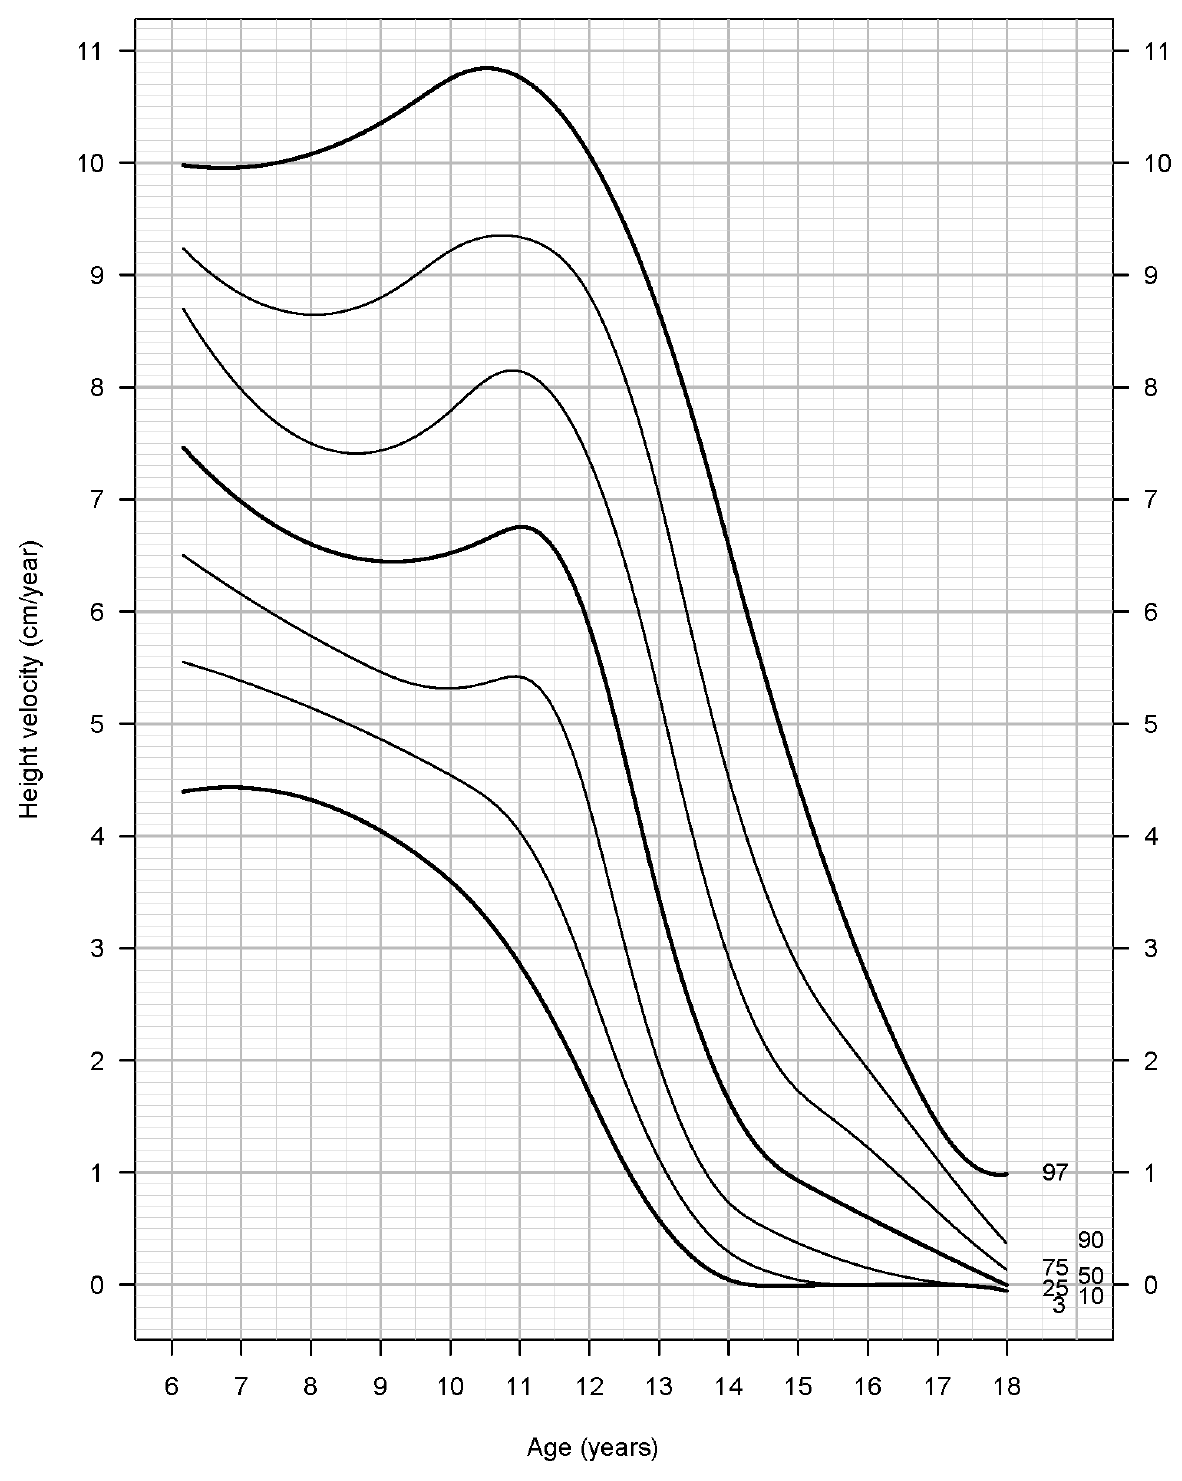
Figure 2. Height velocity for